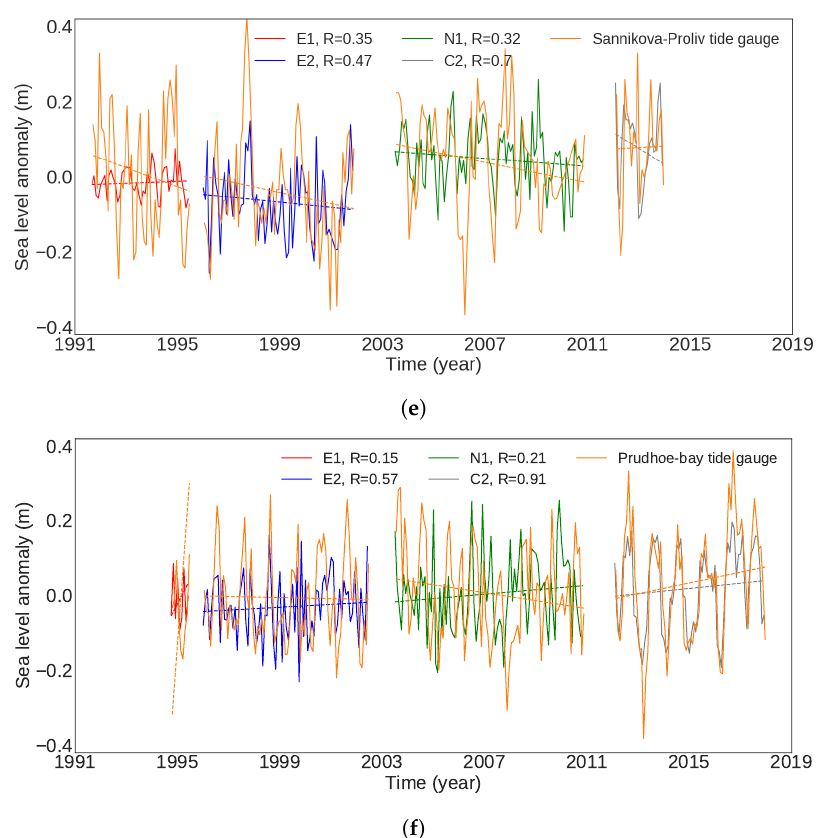
Figure 8. Tide gauge comparison of the six tide gauges for each satellite period, where red (ERS-1), blue (ERS-2), green (Envisat) and grey (CryoSat-2) are the altimetric data and orange is the tide gauge data. The tide gauges are evaluated relative to each individual satellite and accordingly a gap appear in between the satellites where data overlaps. Also trend lines are shown on the figures. ( a ) Honningsvåg.